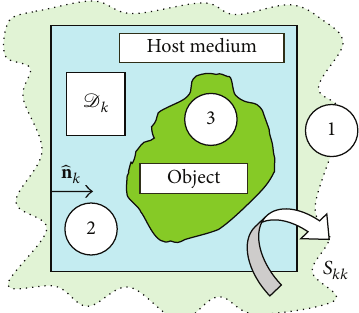
Figure 1: A 3D EM brick D 𝑘 immersed in a background medium ( A ) encloses an anisotropic object ( C ) which is surrounded by a host medium ( B ); the EM behavior of D 𝑘 is captured by the scattering operator 𝑆 𝑘𝑘